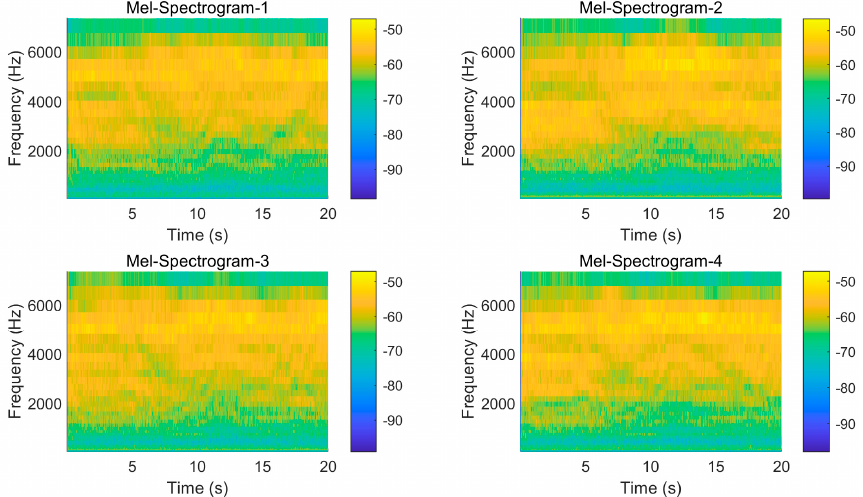
Figure 4. Mel Spectrum.( Sampling frequency 44.1kHz, the darker the color, the higher the absolute value of the decibel number (with negative sign)).